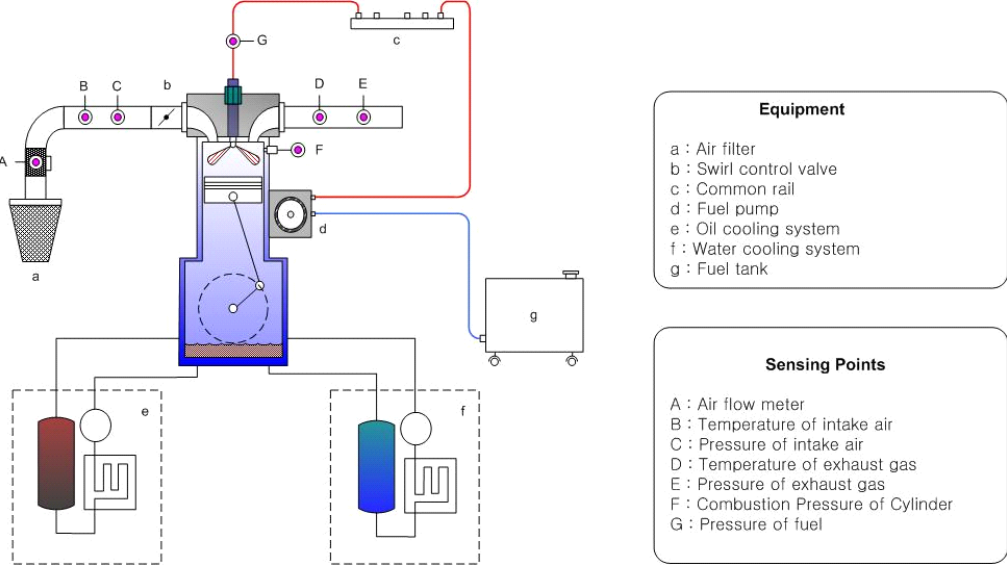
Figure 1. Experimental apparatus for analysis of the combustion and exhaust performance in a HCCI engine.